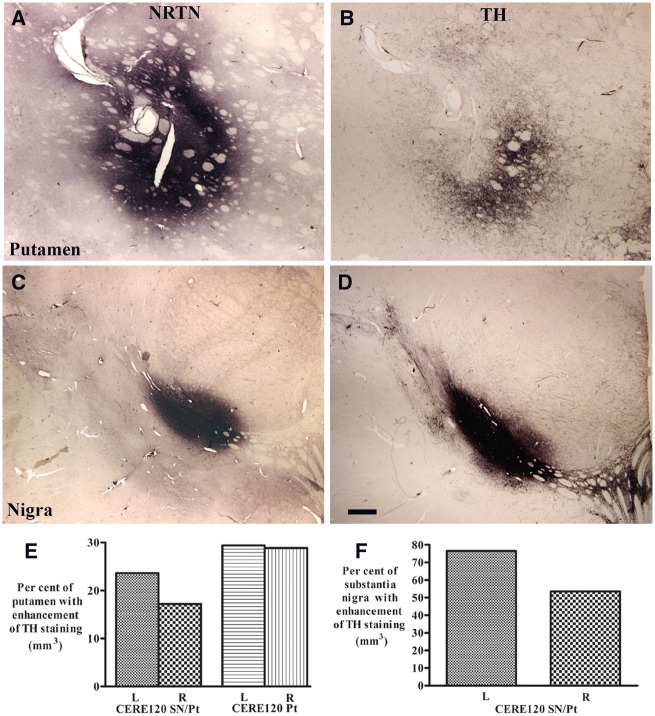

TH expression was enhanced in area with NRTN distribution. Photomicrographs of putamen (A and B) and substantia nigra (C and D) from Parkinson’s disease with combined nigral and putamenal CERE120 administration illustrating neurturin (NRTN; A and C) and TH (B and D) immunohistochemical staining. Note that the TH immunostaining area constituted a relatively large proportion of the NRTN-immunohistochemical footprint. Scale bar in D = 1 mm (applies to all). Quantification of TH staining area revealed a proportion of putamen (E) and substantia nigra (F) displaying an enhanced TH expression.